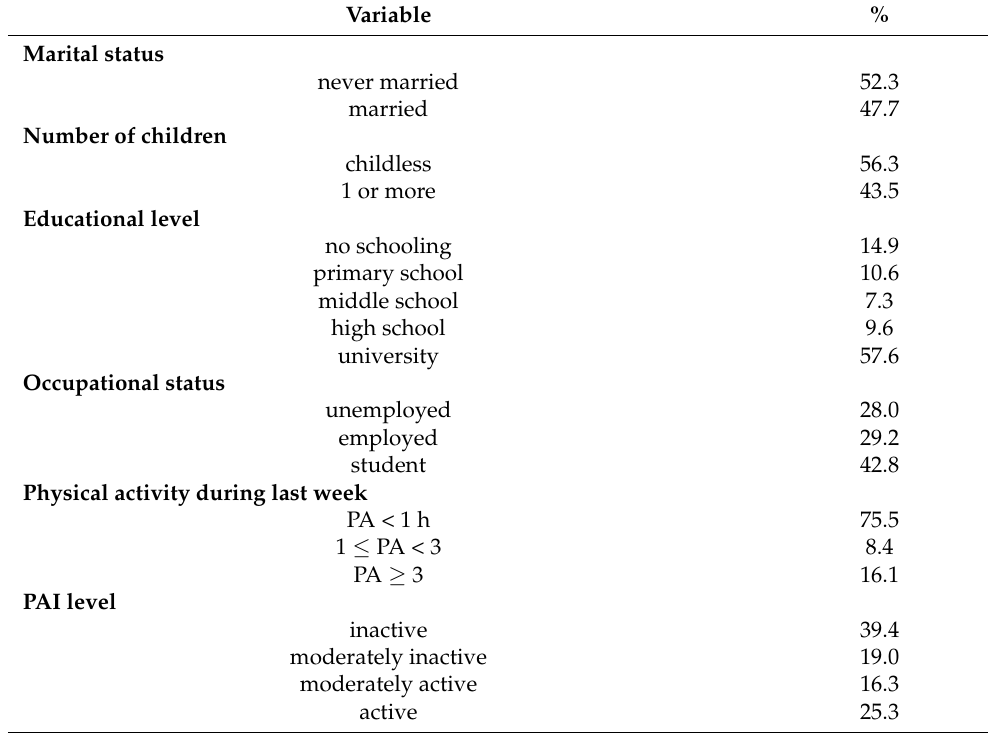
Table 2. Socio-demographic characteristics and PA practice of the Moroccan sample ( n = 304).